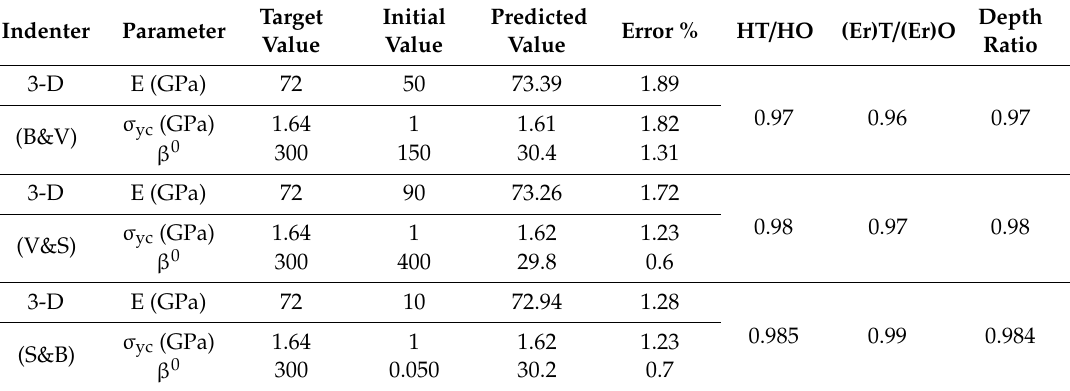
Table 3. Dual indenter optimization results of hydrostatic stress sensitive (bulk metallic glasses, BMG) material.